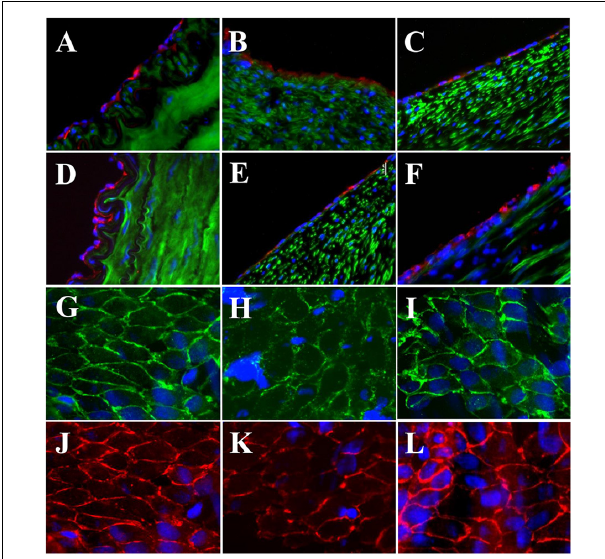
FIGURE 3 | Expression of endothelial biomarkers in neo-endothelial cells of carotid patch-angioplasty in 2-M Group and in 4-M Group. (A–F) Transverse. (A) Factor VIII in native artery. (B) Factor VIII in 2-M Group. (C) Factor VIII in 4-M Group. (D) eNOS in native artery. (E) eNOS in 2-M Group. (F) eNOS in 4-M Group. (G–L) : En face. (G) VE cadherin in native artery. (H) VE cadherin in 2-M Group. (I) VE cadherin in 4-M Group. (J) PECAM-1 in native artery. (K) PECAM-1 in 2-M Group. (L) VE cadherin in 4-M Group. Red in (A–C) anti-Factor VIII. Red in (D–F) anti-eNOS. Green in (A–F) anti-SMC α -actin. Green in (G–I) anti-VE cadherin. Red in (J–L) anti-PECAM-1. Blue in all: nuclei of cells. Objective: 60 × .